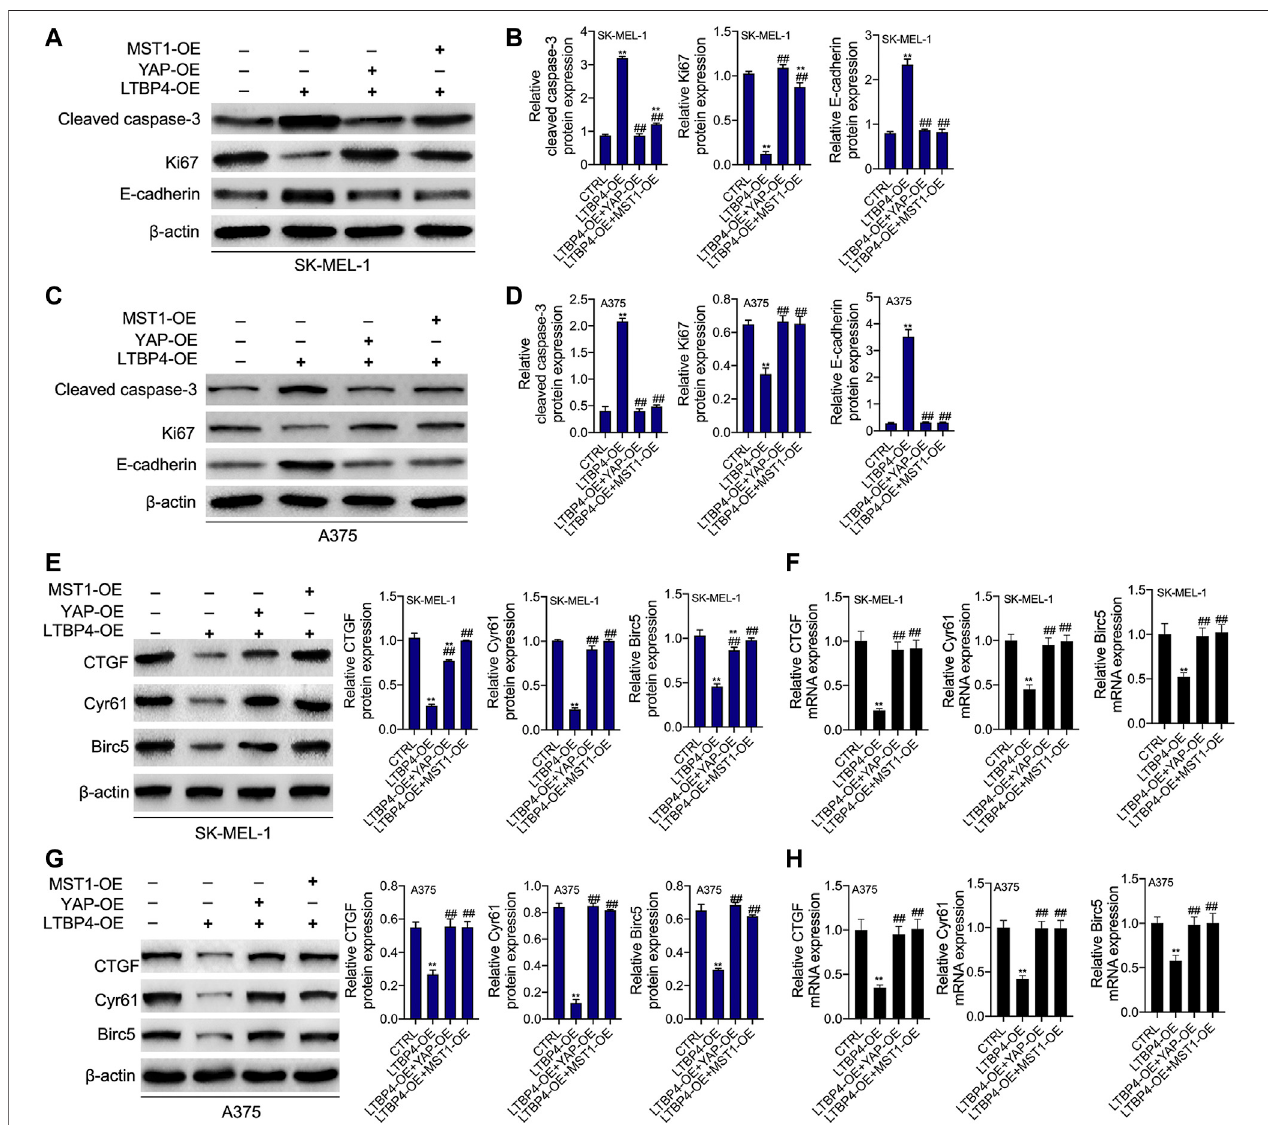
FIGURE 10 | The functions of overexpression of LTBP4 regulating cleaved caspase-3, Ki67, E-cadherin, CTGF, Cyr61, and Birc5 were reversed by YAP1 OE or MST1 OE in melanoma cells. After LTBP4 expressing plasmids and YAP1/or MST1 expressing plasmids were co-transfected into SK-MEL-1 and A375 cells (A and B) the protein levels of cleaved caspase-3, Ki67, and E-cadherin in SK-MEL-1 cells were detected by western blotting assay (C and D) the protein levels of cleaved caspase-3, Ki67, and E-cadherin in A375 cells were detected by western blotting assay (E and F) the protein and mRNA levels of CTGF, Cyr61, and Birc5 in SK- MEL-1cells weredetected bywesternblottingand RT-PCR assays, and (G and H) theprotein and mRNAlevels ofCTGF, Cyr61, and Birc5in A375cellswere detected by western blotting and RT-PCR assays. β -actin was used as a load control. Dataare presented as the mean ± standard deviation. ** p < 0.01 vs CTRL group and ## p < 0.01 vs LTBP4-OE